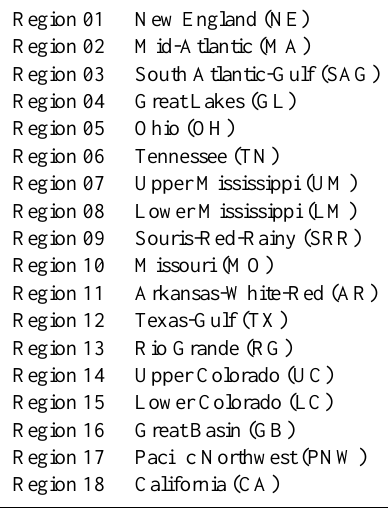
Table 1. List of USGS water resources